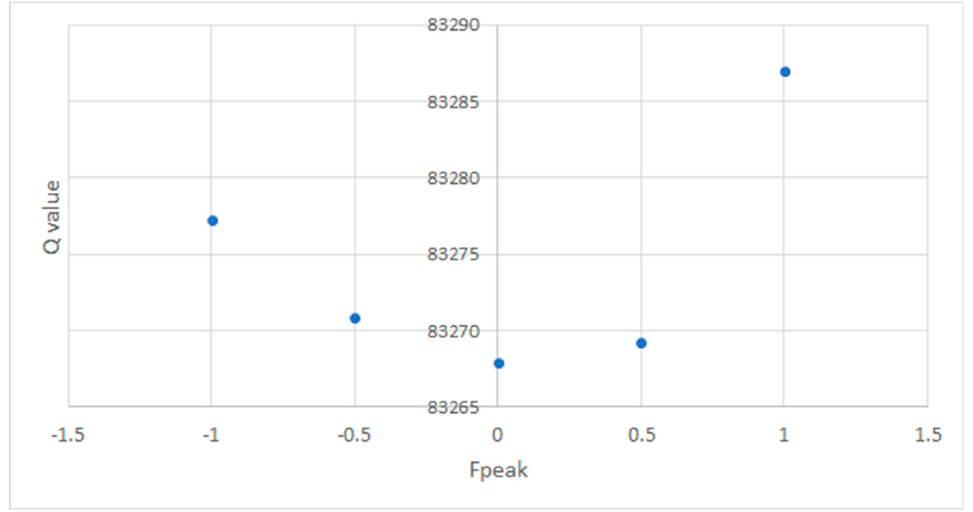
Figure A2. Q value determined for five factors for different Fpeak .